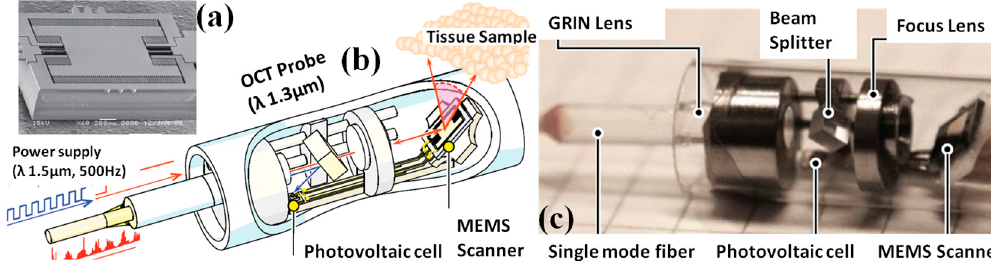
Figure 6. MEMS based optically powered OCT endomicroscope system. ( a ) SEM images of SOI bulk-micromachined optical scanner with electrostatic vertical comb-drive mechanism. ( b ) Schematic drawing of the optically controlled OCT endomicroscope. A light source of 10 mW at 1.5 µm in wavelength is used to transmit actuation energy, which is converted into voltage by the photovoltaic cell. OCT measurement is performed with another source of wavelength 1.3 µm. ( c ) Photograph of the endomicroscope head (Reproduced with permission from IEEJ [52]).